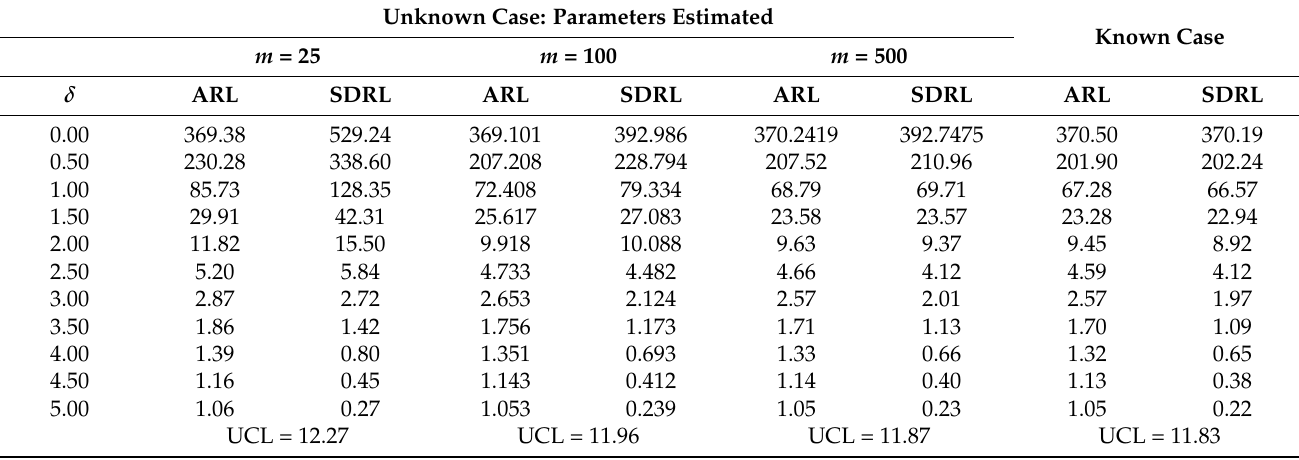
Table 1. ARL and SDRL values of the multivariate Shewhart control chart with p = 2. Unknown Case: Parameters